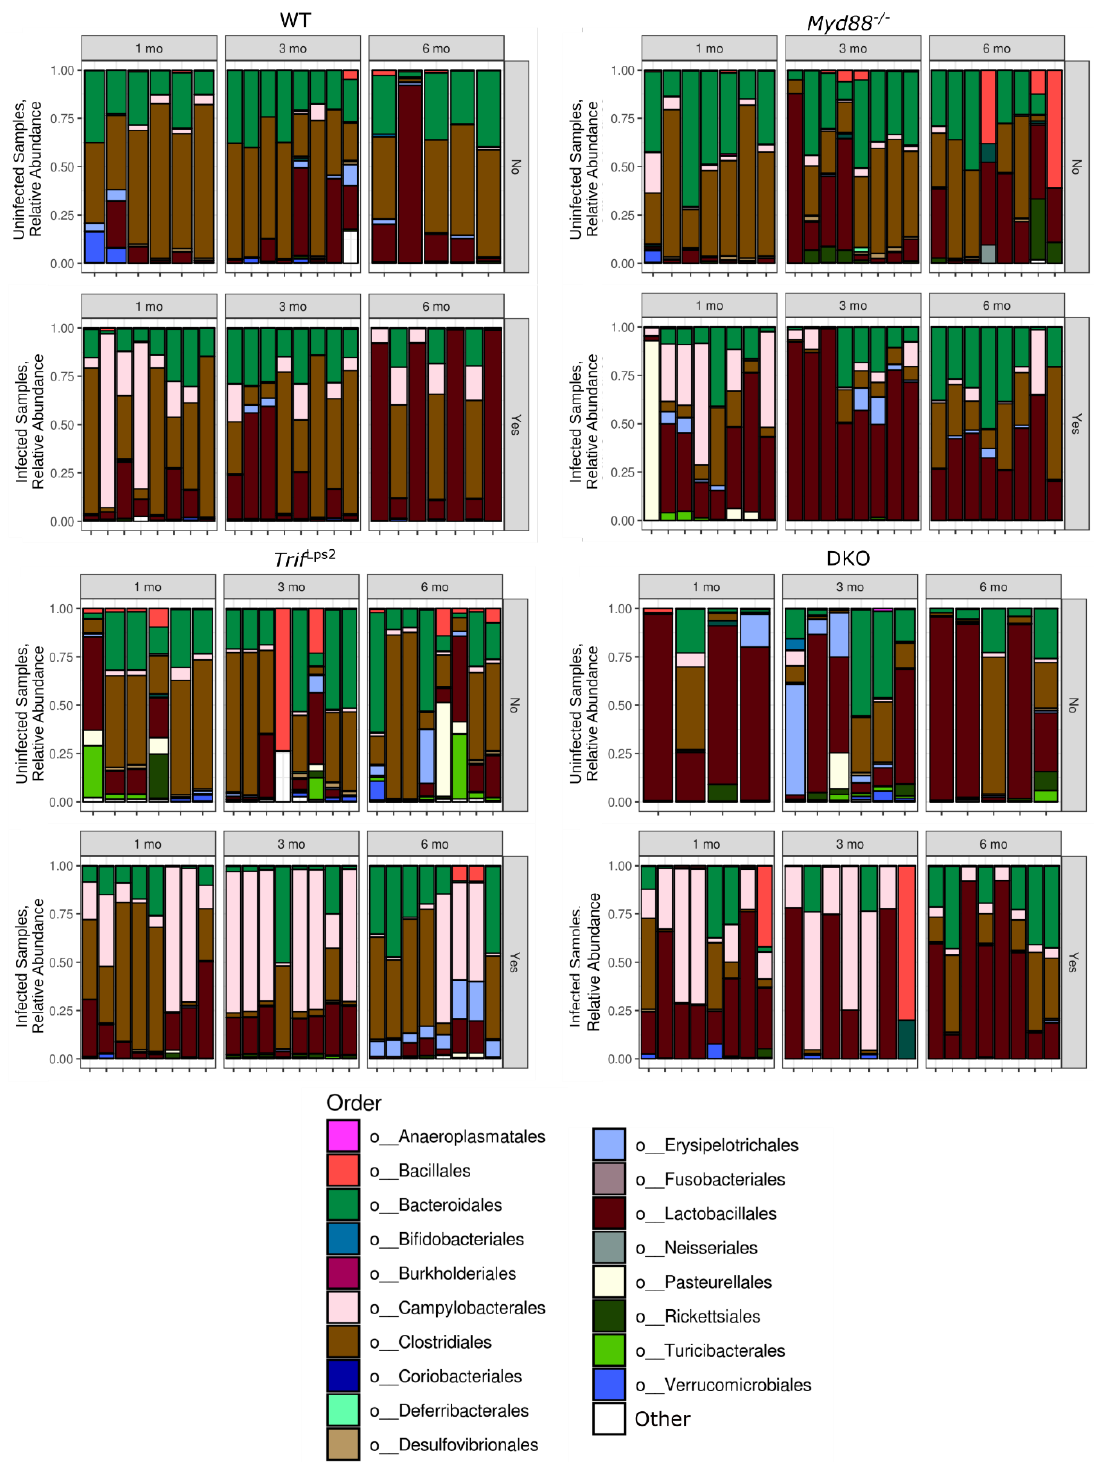
Figure 3. Relative abundance of different orders across four genotypes. Relative abundance of the top 15 orders from WT, Myd88 − / − , Trif Lps2 , and DKO genotypes. Remaining phyla are grouped into “Other”. Samples are grouped into Helicobacter -infected and non- Helicobacter -infected and divided by time point. Sequencing data were processed in QIIME2, then plotted in PhyloSeq.